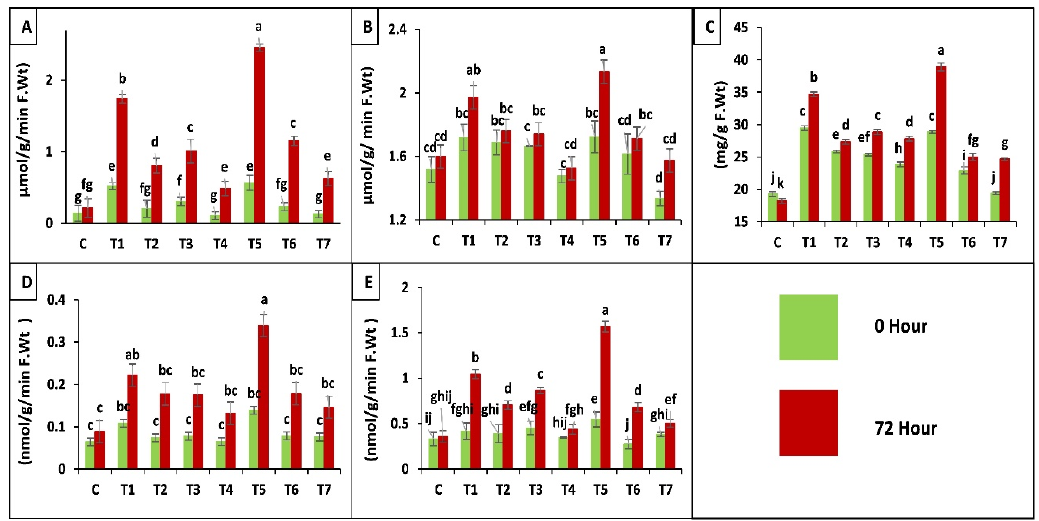
Figure 6. Effect of entomopathogenic fungi on POD ( A ); SOD ( B ); proline ( C ); protease ( D ) and PPO ( E ) activity of plants at 0 h and 72 h of insect attack. Treatment detail: uninoculated and uninfested control ( C ); seed coating with B. bassiana OFDH1-5 (T1); soil drenching with B. bassiana OFDH1-5 (T2); seed coating with T. asperellum GDFS1009 (T3); soil drenching with T. asperellum GDFS1009 (T4); seed